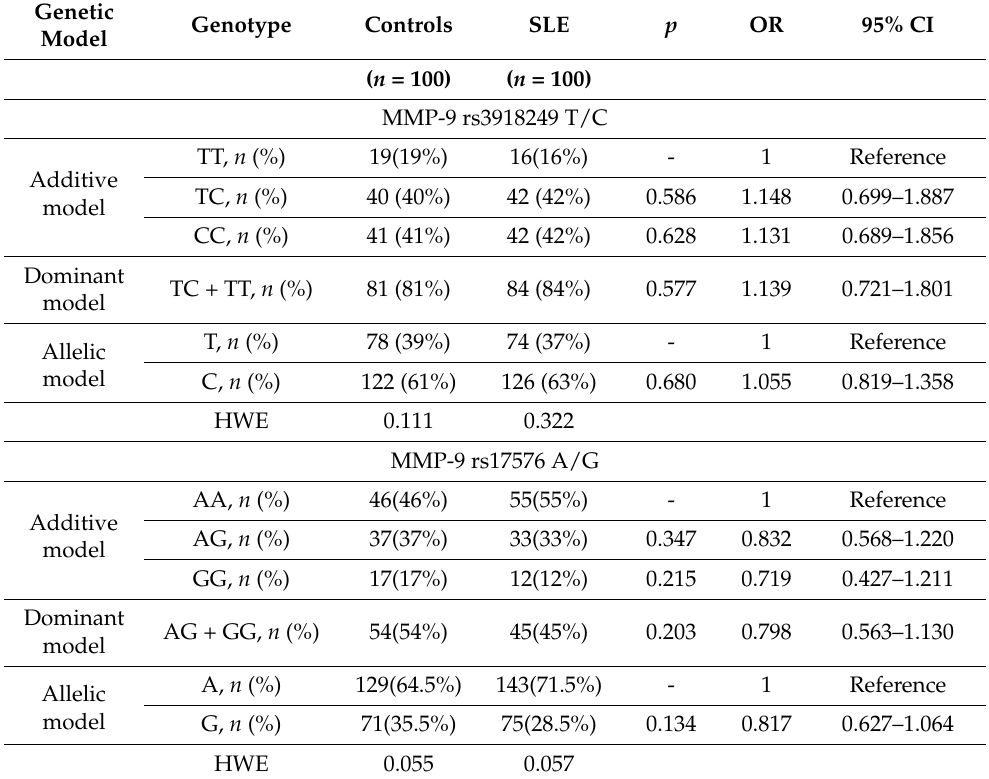
Table 3. Gelatinase B/MMP-9 rs3918249 T/C and rs17576 A/G alleles, and genotypes, both the SLE study participants and the healthy controls.